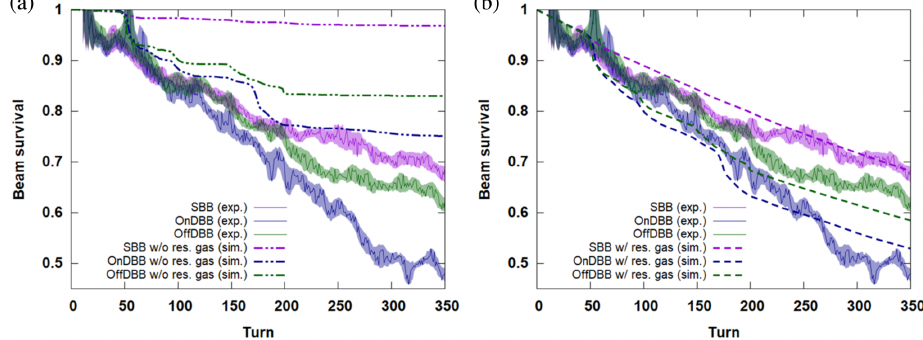
FIG. 11. Beam survival comparison of the experimental and simulation results: (a) without and (b) with beam loss by residual gas interactions.